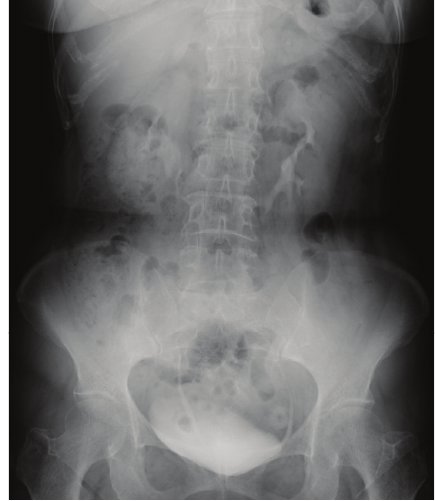
Figure 2: Intravenous urography of the donor revealed a medially rotated pelvis. Bilateral collecting systems were not connecting, and hydronephrosis was not seen.